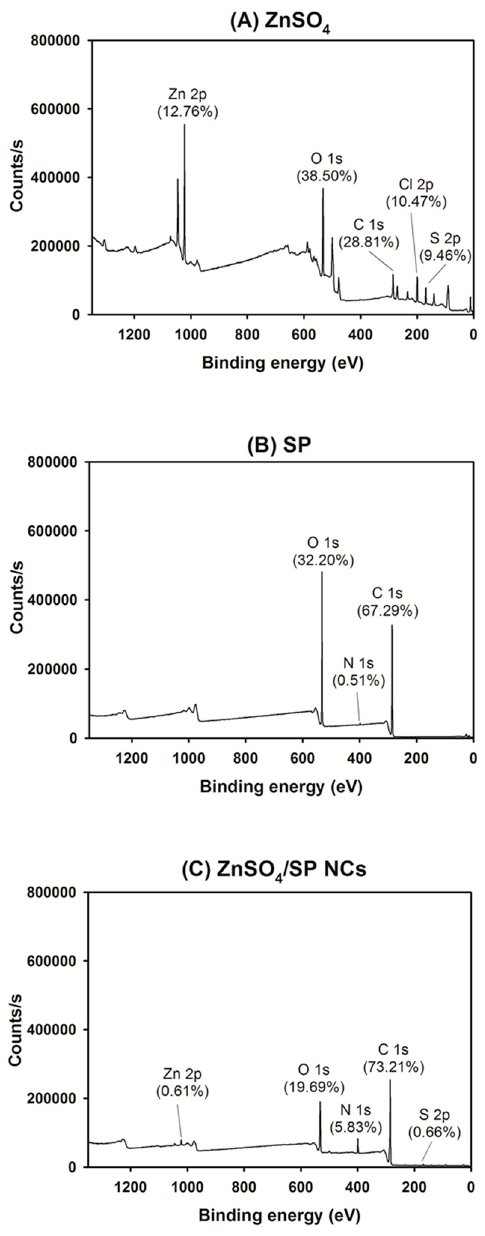
Figure 4. XPS profiles of ( A ) ZnSO 4 , ( B ) SP, and ( C ) ZnSO 4 /SP NCs. Counts/s according to binding energy is plotted. The atomic percentage is shown in the graph.